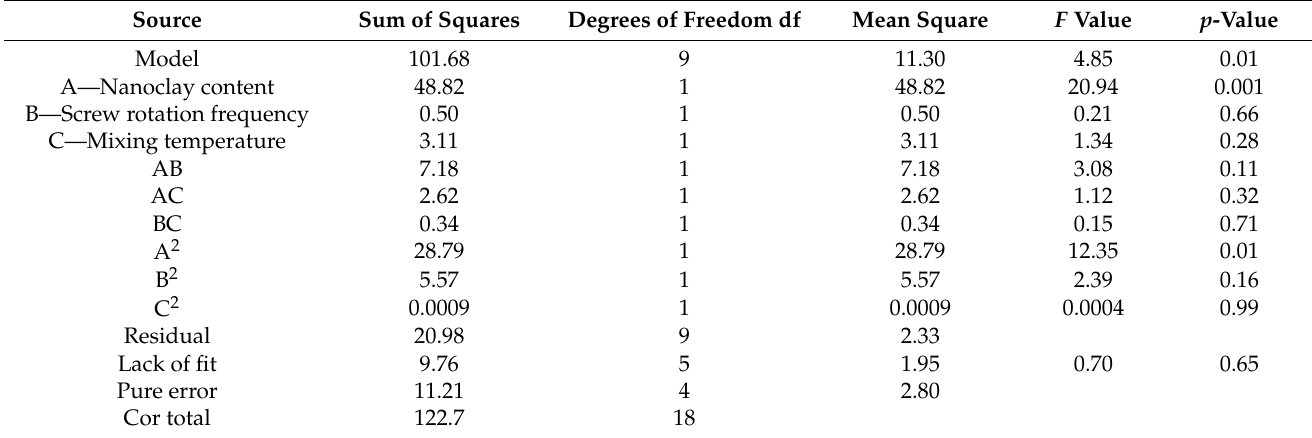
Table 4. Analysis of variance for the quadratic regression model: flexural strength.